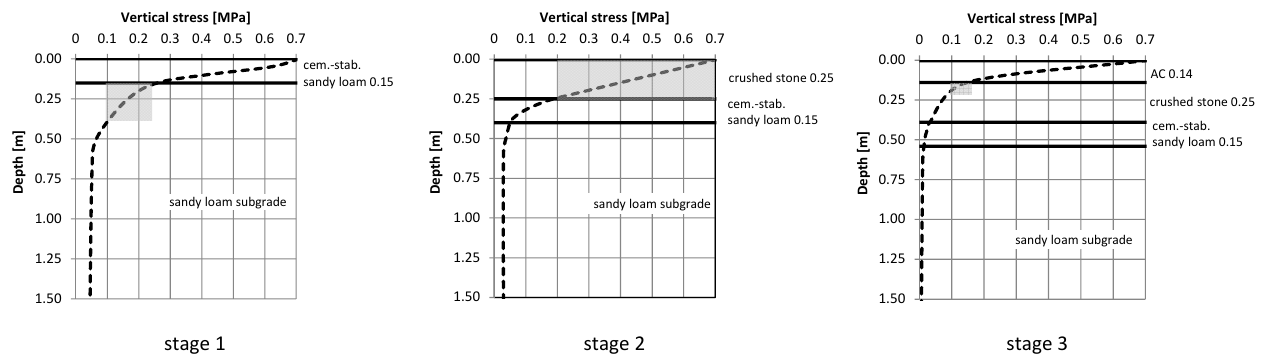
Figure 15. Distribution of vertical stresses in exploited systems, at various stages of construction and in the target system of layers of the pavement structure. It Is worth noting that, in the case of stage 1, the stresses in the subgrade are apparently low at 0.17 MPa on average, but they cause high micro-deformations 5420, which translates into the durability of only 19 axes. For stage 2 (with an additional layer of stone), stresses of 0.04 MPa are present in the subgrade, ensuring durability for the subgrade 13,001 axes. In the aggregate layer, despite the high level of stresses and, at the same time, the high value of the modulus, relatively small micro-deformations (697) occur, which ensure the durability of the axis for this layer. In the final structure (stage 3), the durability of the subgrade is 1,848,994 axes, and the aggregate layers are 75,180,511 axes. The comparison of deformation values and subgrade durability for different stages is shown in Figure 16.